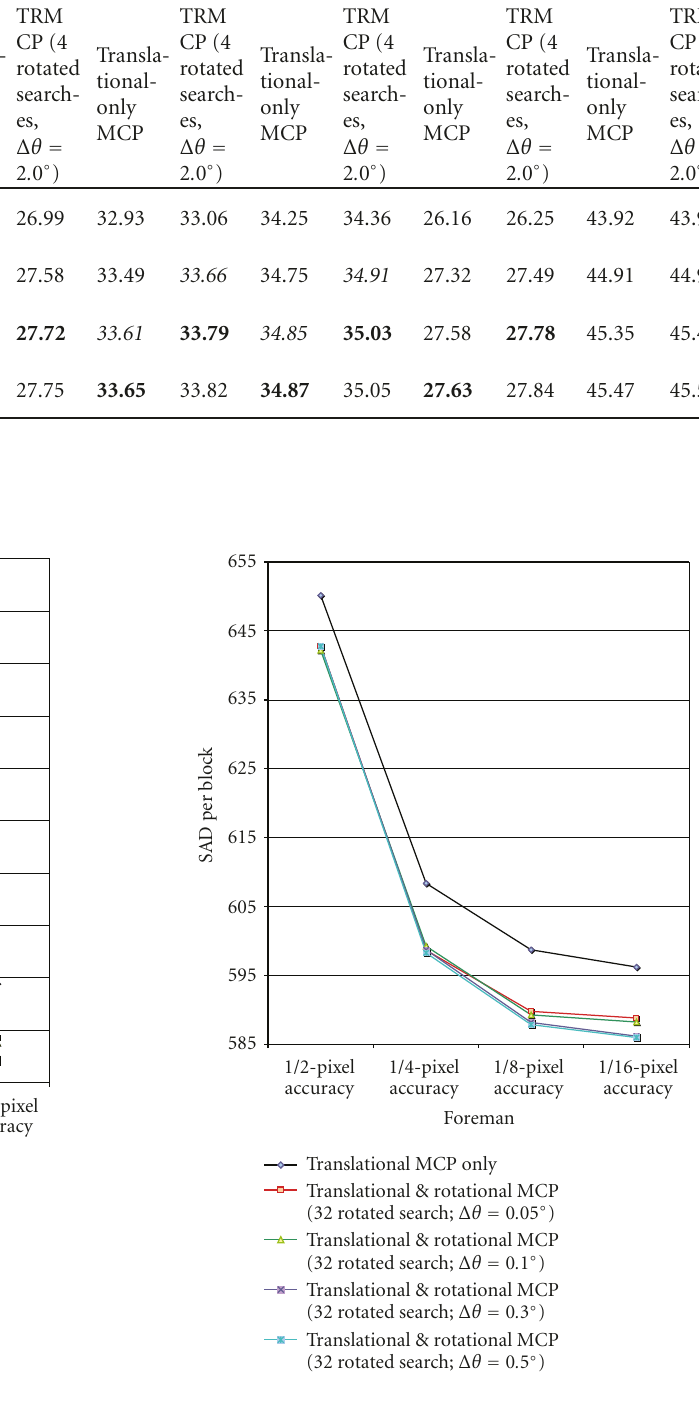
Figure 6: Average SAD per block in sequence Crew . Figure 7: Average SAD per block in sequence Foreman